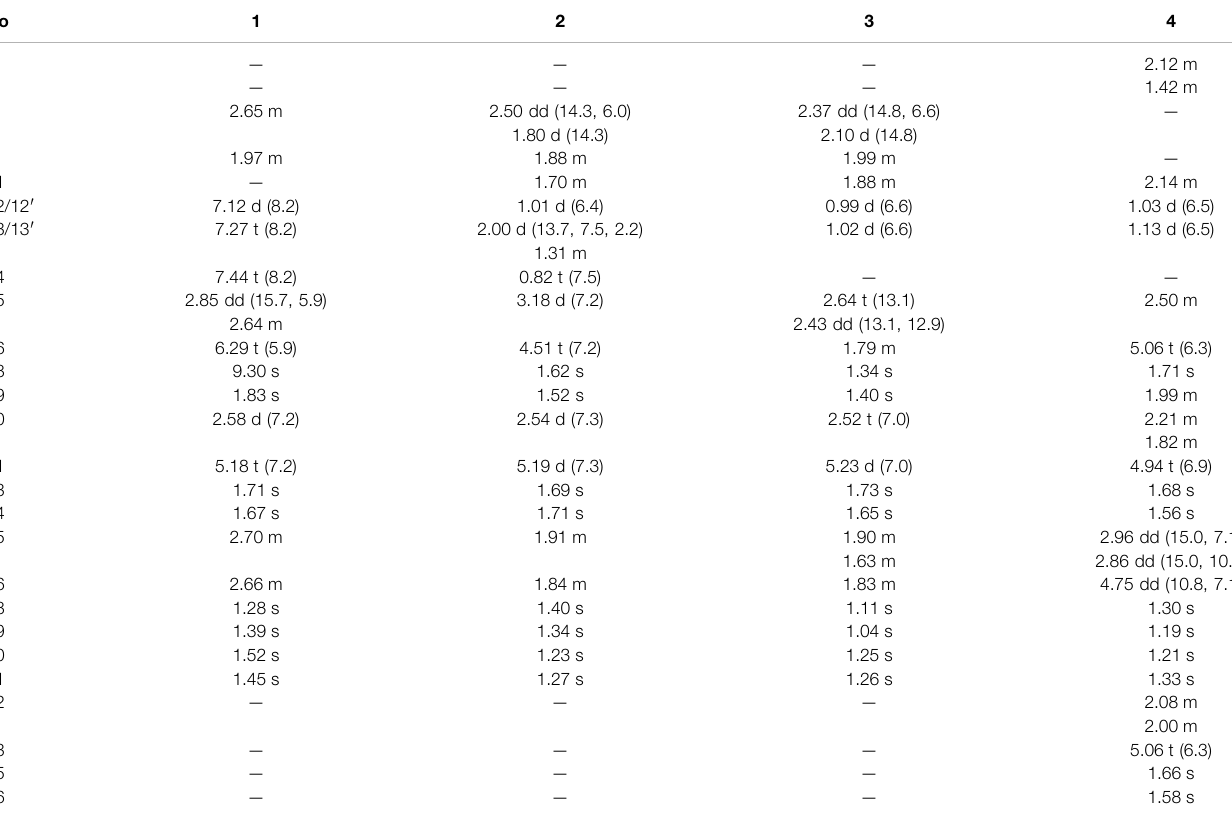
TABLE 1 | 1 H NMR (600 MHz) data of compounds 1-4 in CDCl 3 ( δ in ppm, J in